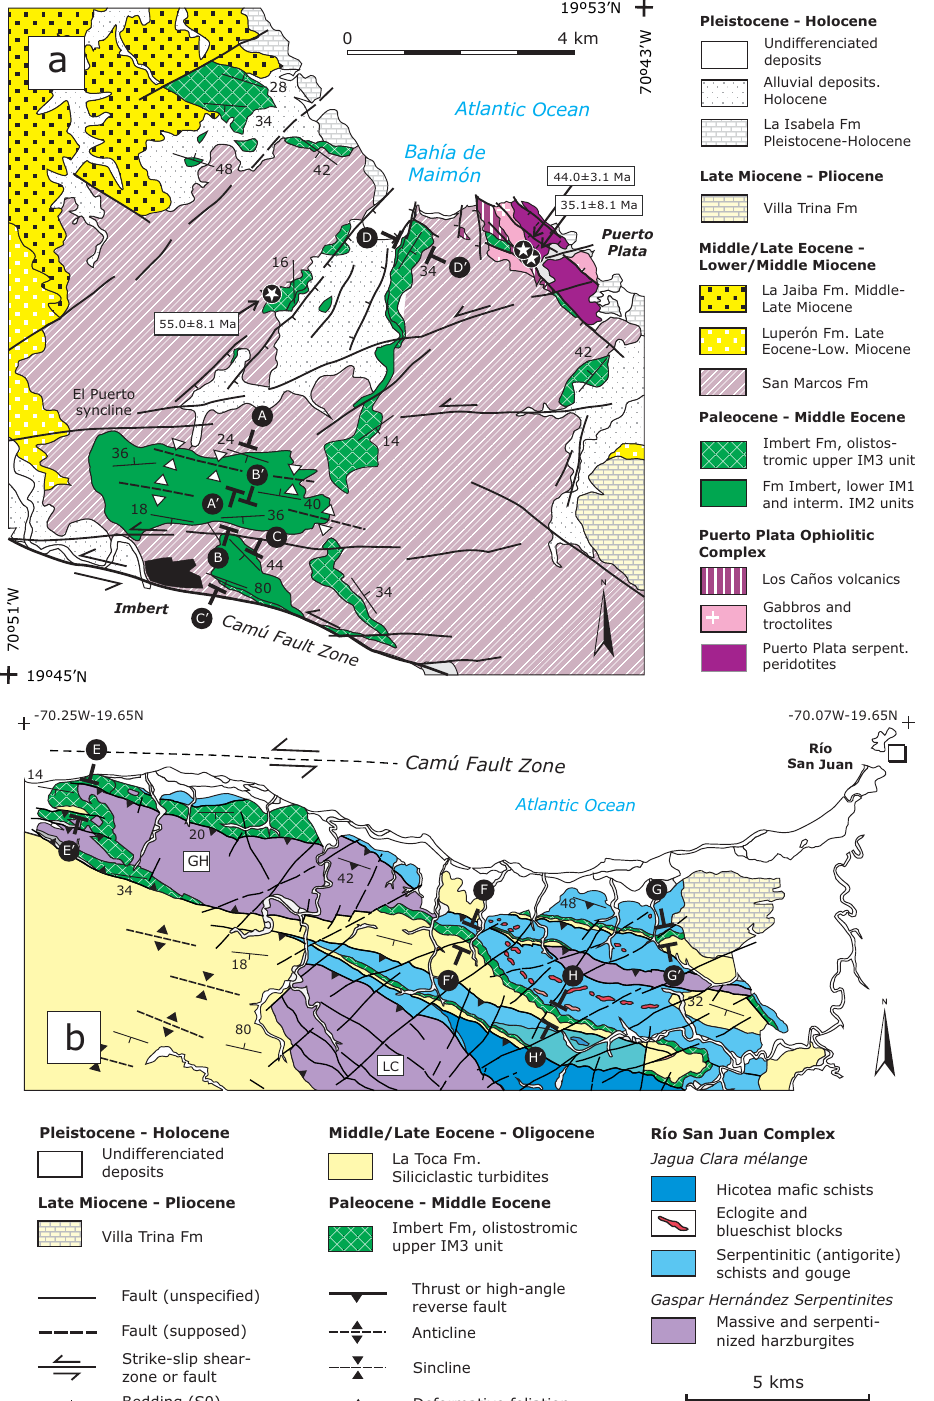
Figure 2. (a) Simplified geological map of Puerto Plata ophiolitic complex modified from Draper and Nagle (1991), Hernáiz-Huerta (2010), Escuder-Viruete et al. (2014) and Suárez-Rodríguez et al. (2015), showing locations of the El Puerto (A–A (cid:48) ), Rancho Brugal (B–B (cid:48) ), Río Obispo (C–C (cid:48) ) and Loma Seboruco (D–D (cid:48) ) sections, the location of the samples dated by 40 Ar / 39 Ar method, and representative bedding orientations of rocks. (b) Simplified geological map of northernmost Río San Juan complex modified from Escuder-Viruete et al. (2013), showing locations of the Gaspar Hernández (E–E (cid:48) ), Magante (F–F (cid:48) ), Caño Claro (G–G (cid:48) ) and Hicotea (H–H (cid:48) ) sections, as well as represen- tative bedding orientations of rocks. Sample location (Lat/Long): 10JE54; − 70,74356/19,82547, JM9112; − 70,74436/19,82614, HH9124; − 70,80958/19,81107.